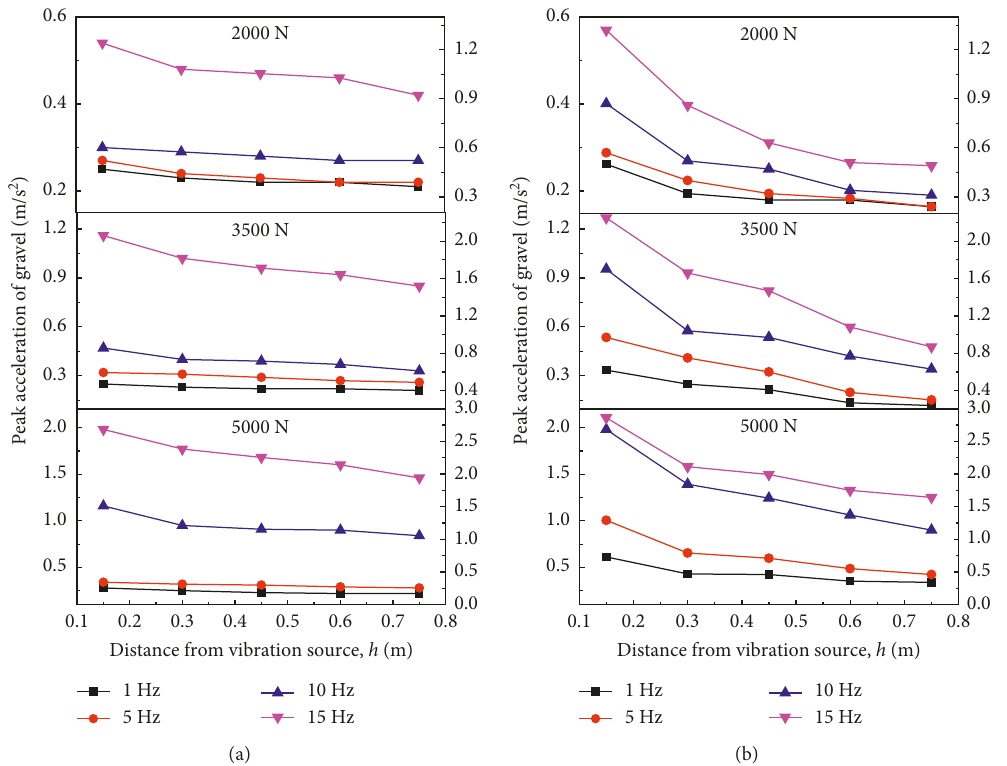
Figure 21: Peak acceleration for subgrade filled with gravel under (a) single jack and (b) three jacks.